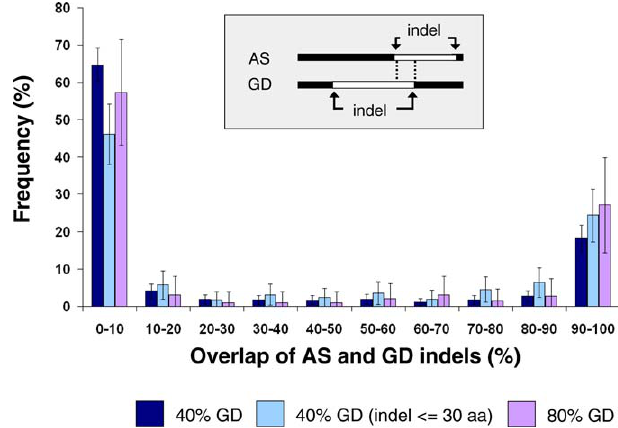
Figure 6. The Size Distribution of Insertions/Deletions in AS and GD All analyses of indels have been made for gene families with both AS and GD (i.e., AS þ /GD þ ). (A) AS indels are longer than GD indels. Indels for GD were obtained from the alignments of GD families at 40% (dark red) and 80% (light violet) seq.id. Information on AS indels (green) was obtained from the SwissProt record of the corresponding protein. Indel size distributions for both GD40 and GD80 are very similar, with most of the indels being shorter than five residues. In contrast, many AS indels are longer than 100 residues.